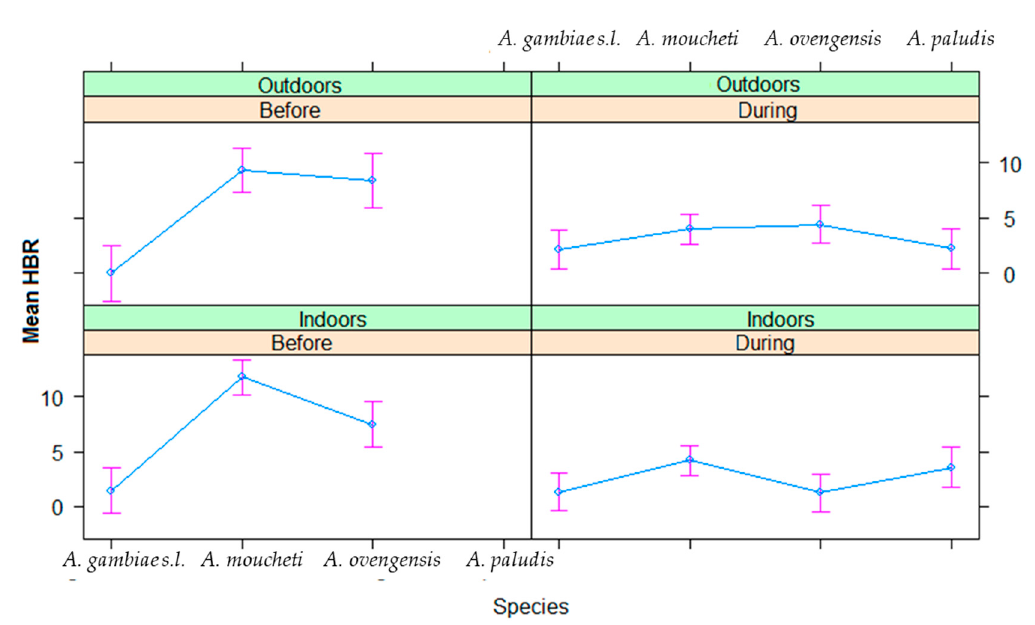
Figure 7. E ff ect plot showing the estimated mean HBRs in outdoors versus indoors in Nyabessan before and after dam construction.